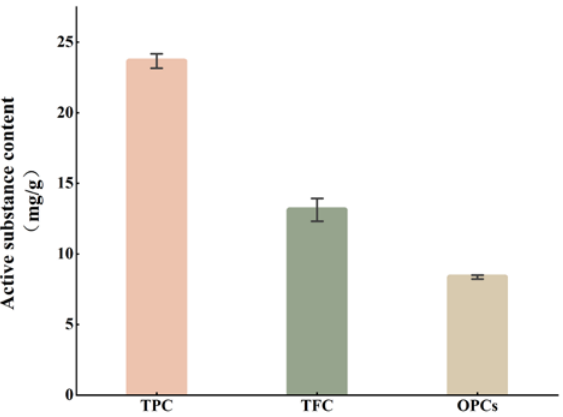
Figure 2. Active substance content of